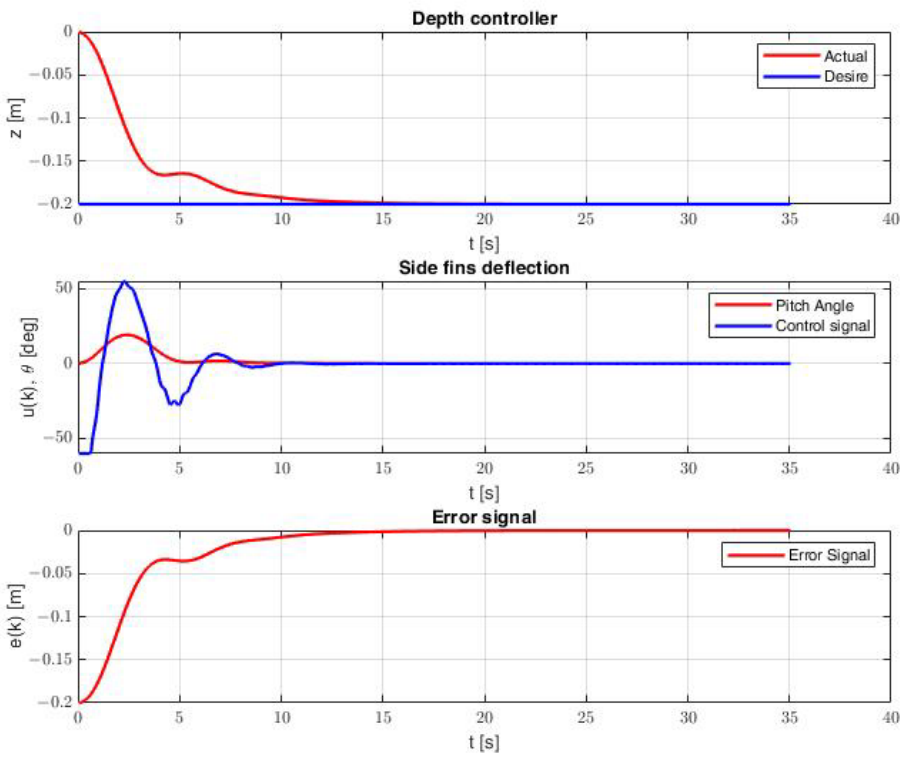
Figure 5. Changes of immersion and side fins deflection in time in response to desired depth: 0.2 [m] obtained for PID controller settings using GA method and fitness function no. 3 for two depth changes.